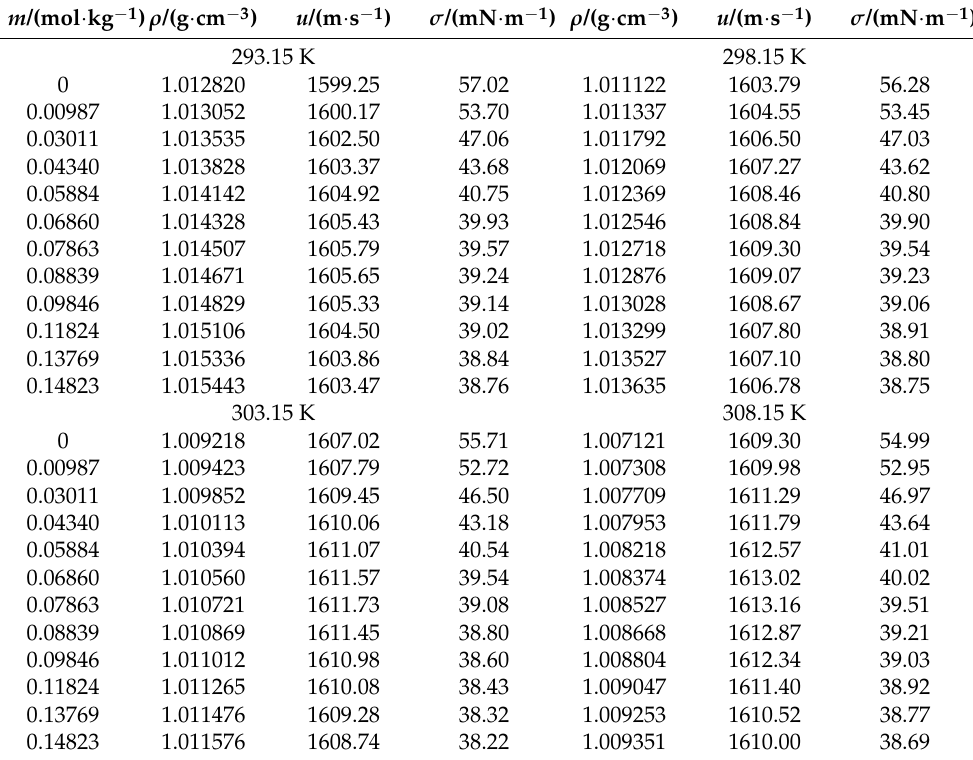
Table 4. Density, sound velocity, and surface tension for decyltrimethylammonium bromide (C 10 TAB) in aqueous solutions of 1,2-propanediol X OH = 0.04963 at temperatures between T = 293.15 K and 308.15 K at 75